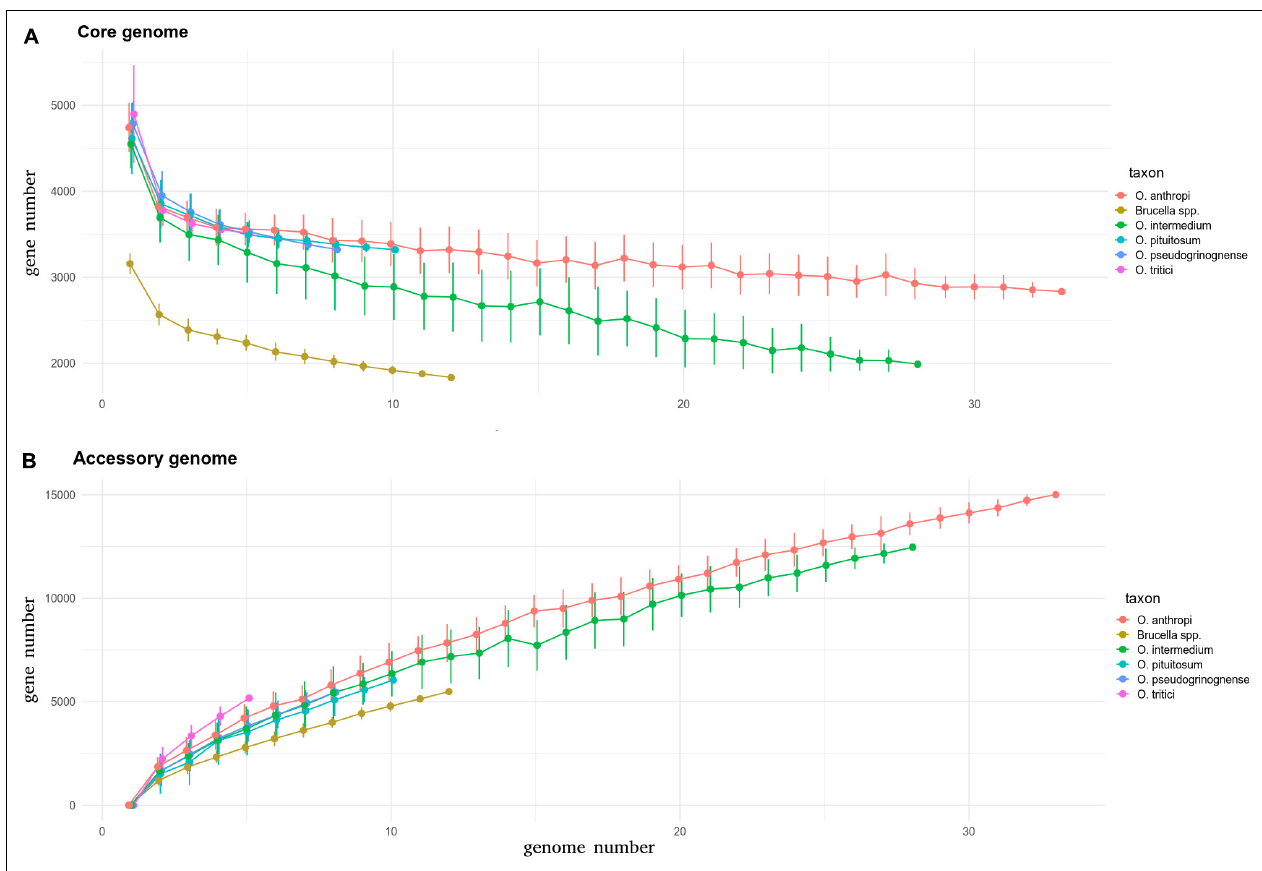
FIGURE 3 | Core (A) and accessory (B) genomes of Brucella and various Ochrobactrum species calculated using an in-house pipeline. For each species, the graph shows the number of genes in core and accessory genomes estimated for an increasing number of considered genomes, up to the number of genomes available for the taxon. The core genome is defined as the set of genes detected in all genomes under consideration. The accessory genome is defined as the total of distinct genes detected in the considered genomes (pan genome) minus the core genome. Since not all taxa have the same number of sequenced genomes, accumulation curves were produced as follows: the number of considered genomes increases from one to the total number of genomes in the taxon, and at each step, the considered genomes are selected randomly in the pool of genomes available for the taxon. This random selection was repeated up to 50 times at each step and median and standard error were estimated for core and accessory gene numbers (see section Materials and